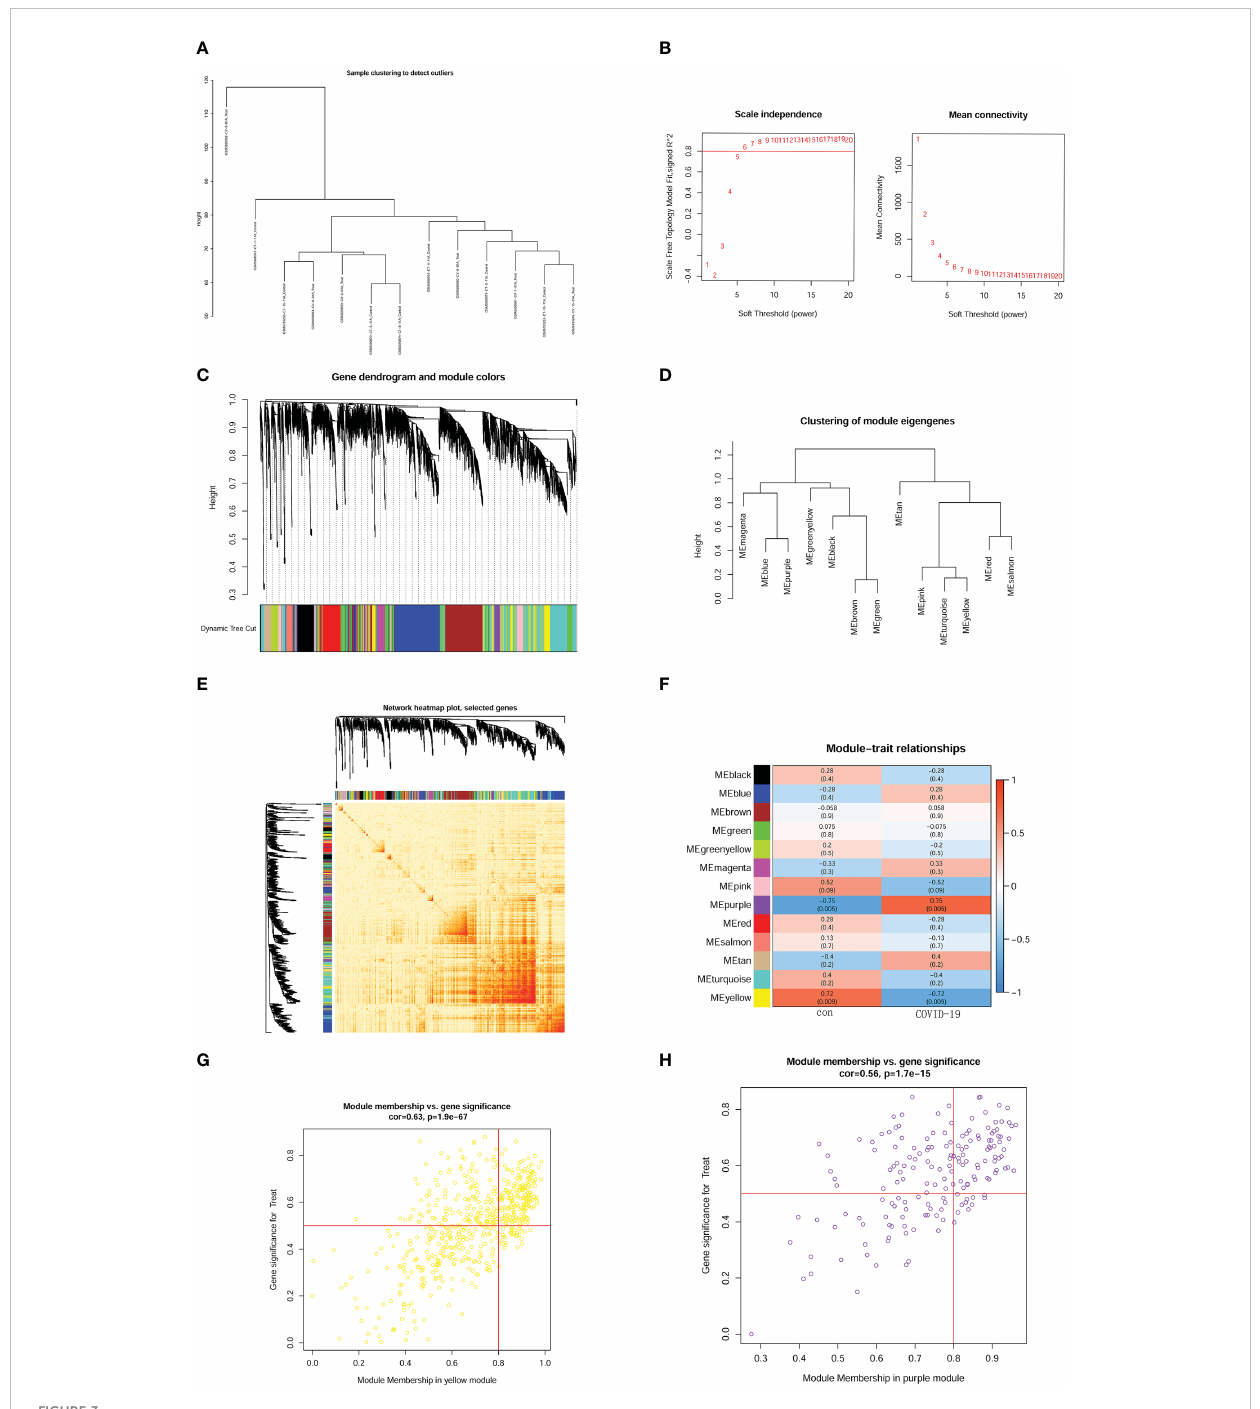
FIGURE 3 Construction of weighted gene network and key module identi fi cation. (A) sample clustering. (B) threshold power con fi rmed. The left panel shows the scale-free fi t index. The right panel represented mean connectivity. (C) gene dendrogram according to the value of dissimilarity measure (1-TOM). (D) enrich analysis of module eigengenes. (E) heatmap of genes based on distance on each other. (F) module-trait relationships and de fi nite relativity and p-value. (G) module membership (MM) vs. gene signi fi cance analysis in MEyellow module. (H) module membership (MM) vs. gene signi fi cance analysis in MEpurple